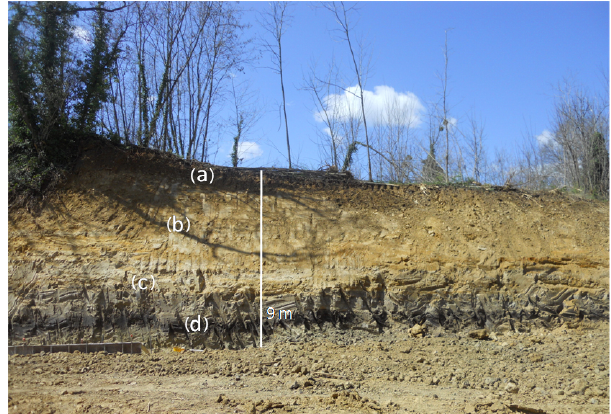
Figure 7. Artificial scarp along the SP11 road, with a representative exposure of the Vallone dell’Aspro deposits. Below a 1m thick soil (a) there are pebbly sands (b) and grey clayey silts (c) . A very dark 40cm thick, organic-matter-rich peaty level can be observed near the base of the outcrop (d)